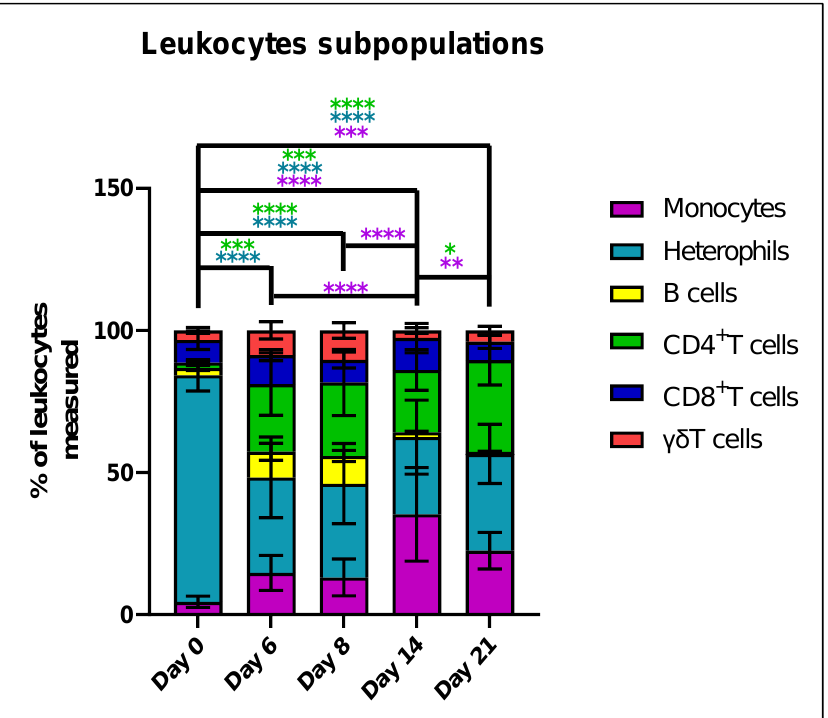
Figure 3. Characterization of temporal shifts in the proportions of chicken leukocyte populations. Whole blood, collected from 10 control birds at each time point, was subjected to flow cytometry to identify changes in leukocyte subpopulations. Results are shown as the percent of total leukocytes measured (CD45+CD41/61 − ). Significant differences were determined using Two-way ANOVA, and pairwise comparisons were completed using Tukey HSD. Results were considered significantly different at a p < 0.05. Significant difference for each cell type are indicated by asterisks color-coded to match the cell type (* = p < 0.05, ** = p < 0.01, *** = p < 0.001, **** = p < 0.0001).